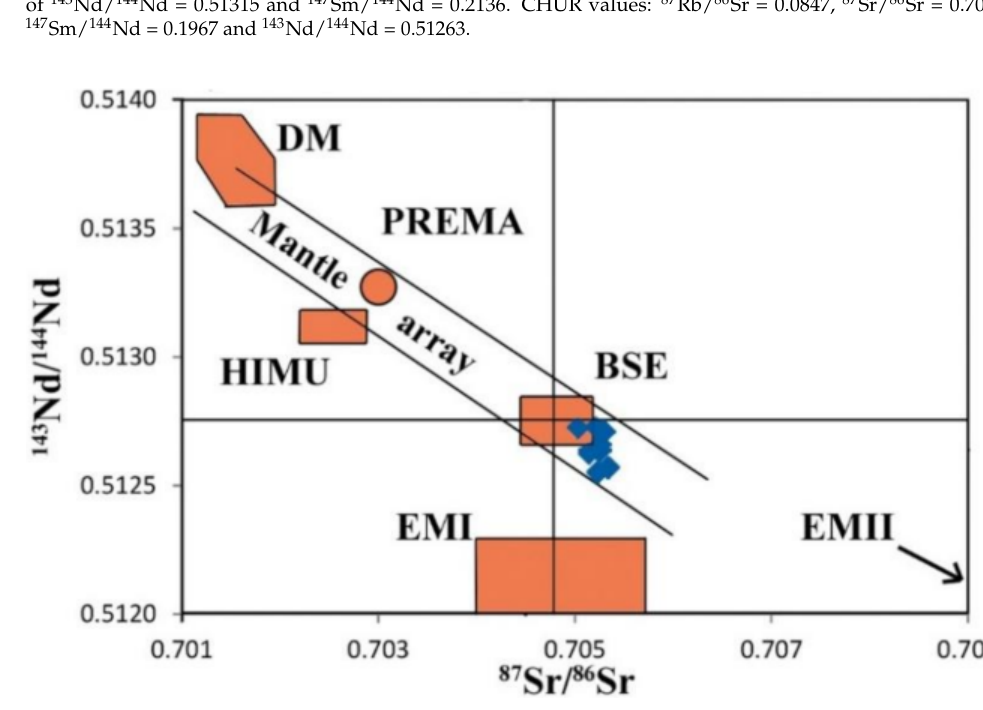
Figure 9. 87 Rb/ 86 Sr versus 87 Sr/ 86 Sr diagram for the dyke swarm rocks. All 9 samples were used in the isochron and age calculations. The bars represent the two-sigma uncertainties. 143 Nd/ 144 Nd versus 87 Sr/ 86 Sr ratio for dyke swarms with the mantle components HIMU, EM1, EM2 and DMM [63]. The positions of the main oceanic mantle reservoirs thus identified are shown: DM = depleted mantle, BSE = bulk silicate earth, EMI and EMII = enriched mantle I and II, HIMU = high mantle U/Pb ratio and PREMA = frequently observed prevalent mantle composition. Many oceanic basalts define the mantle array, and a bulk earth value for 87 Sr/ 86 Sr can be obtained from this